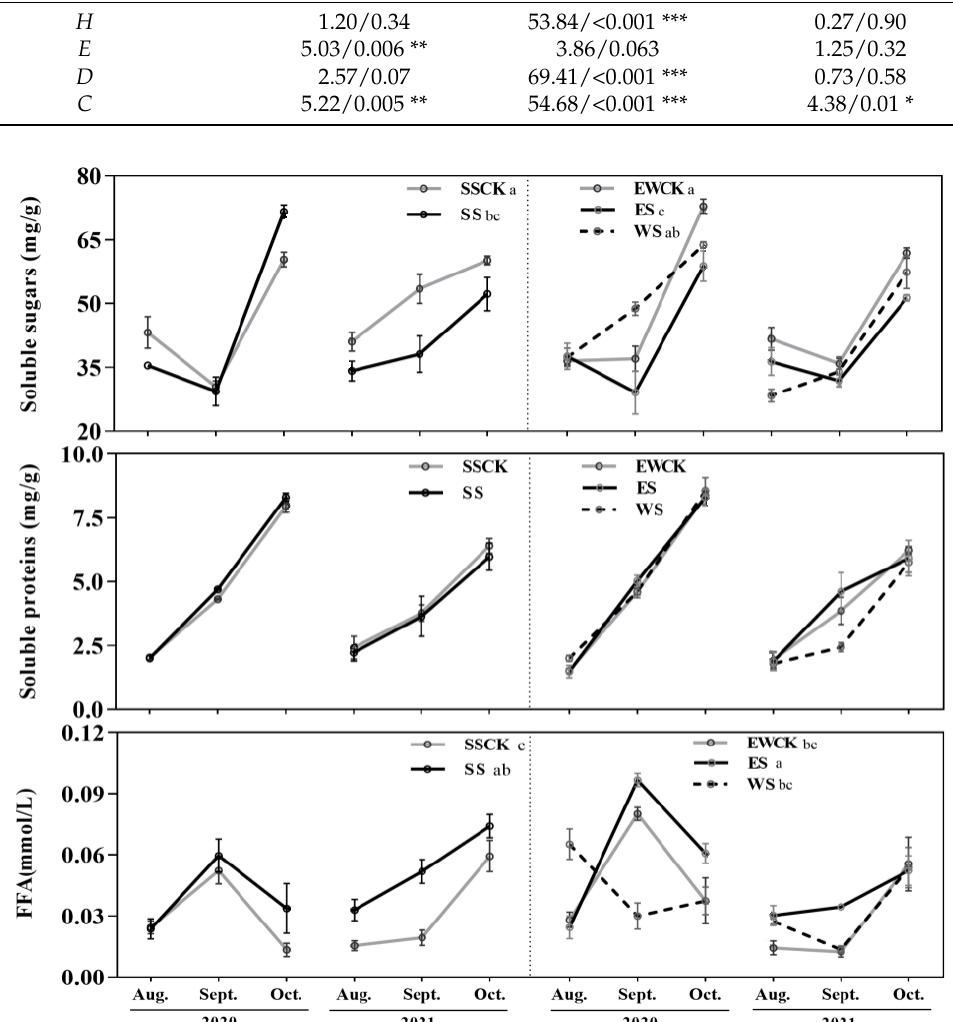
Figure 2. Foliar soluble nutrients of tea plants under the ecological shading treatments by roadside trees in the tea plantation (Note: different lowercase letters indicate significant differences among the ecological-shade treatments, and the control no-shading treatments, using the LSD test at p < 0.05. The same in the following